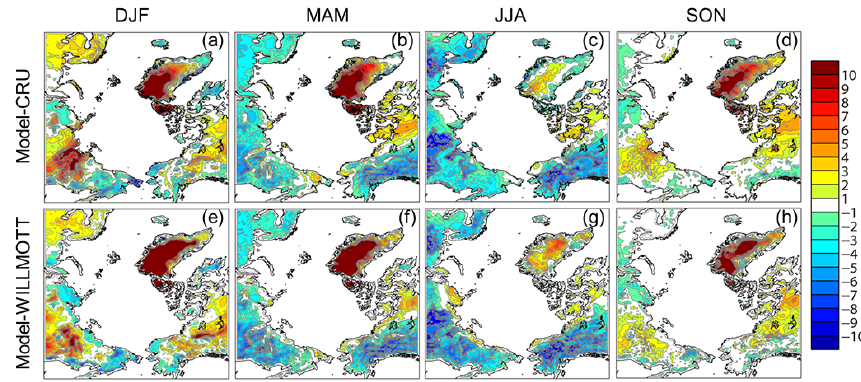
Figure 2. The mean seasonal 2m temperature anomalies ( ◦ C) relative to the CRU and WILLMOT data sets for the period 1961–1990. ( a, e ) Winter, December to February (DJF). ( b, f ) Spring, March to May (MAM). ( c, g ) Summer, June to August (JJA). ( d, h ) Autumn, September to November